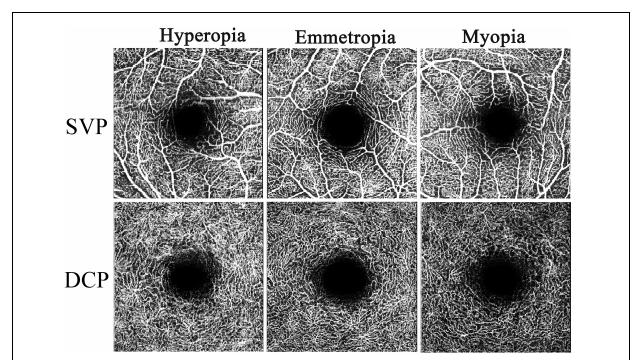
FIGURE 1 | Representative OCTA images of SVP and DCP in hyperopia, emmetropia, and myopia